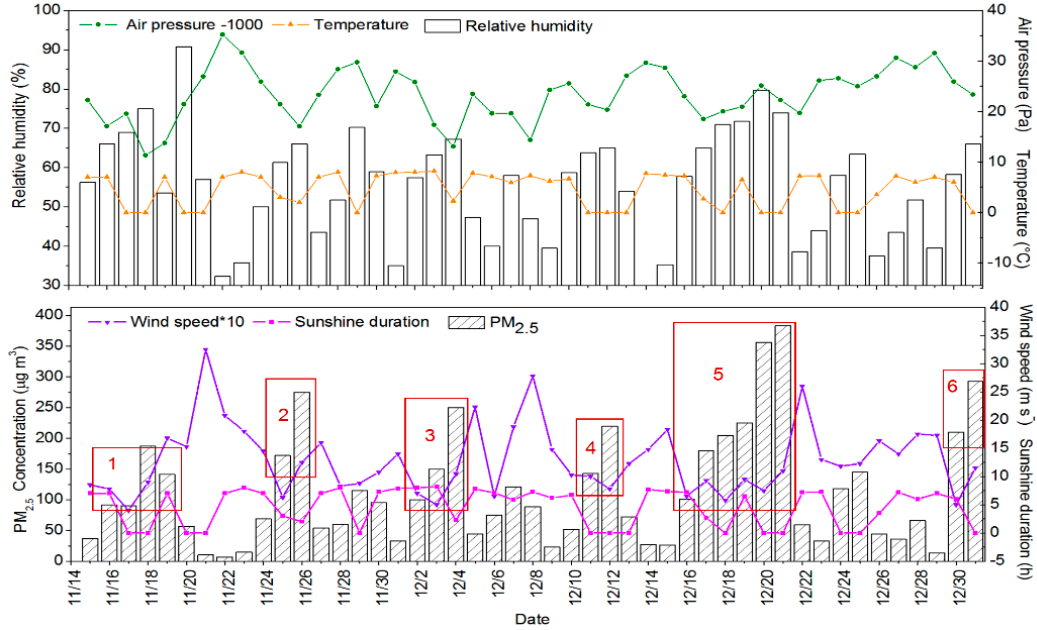
Figure 1. Daily variation of winter PM 2.5 concentration and meteorological variables in Beijing, 2016.